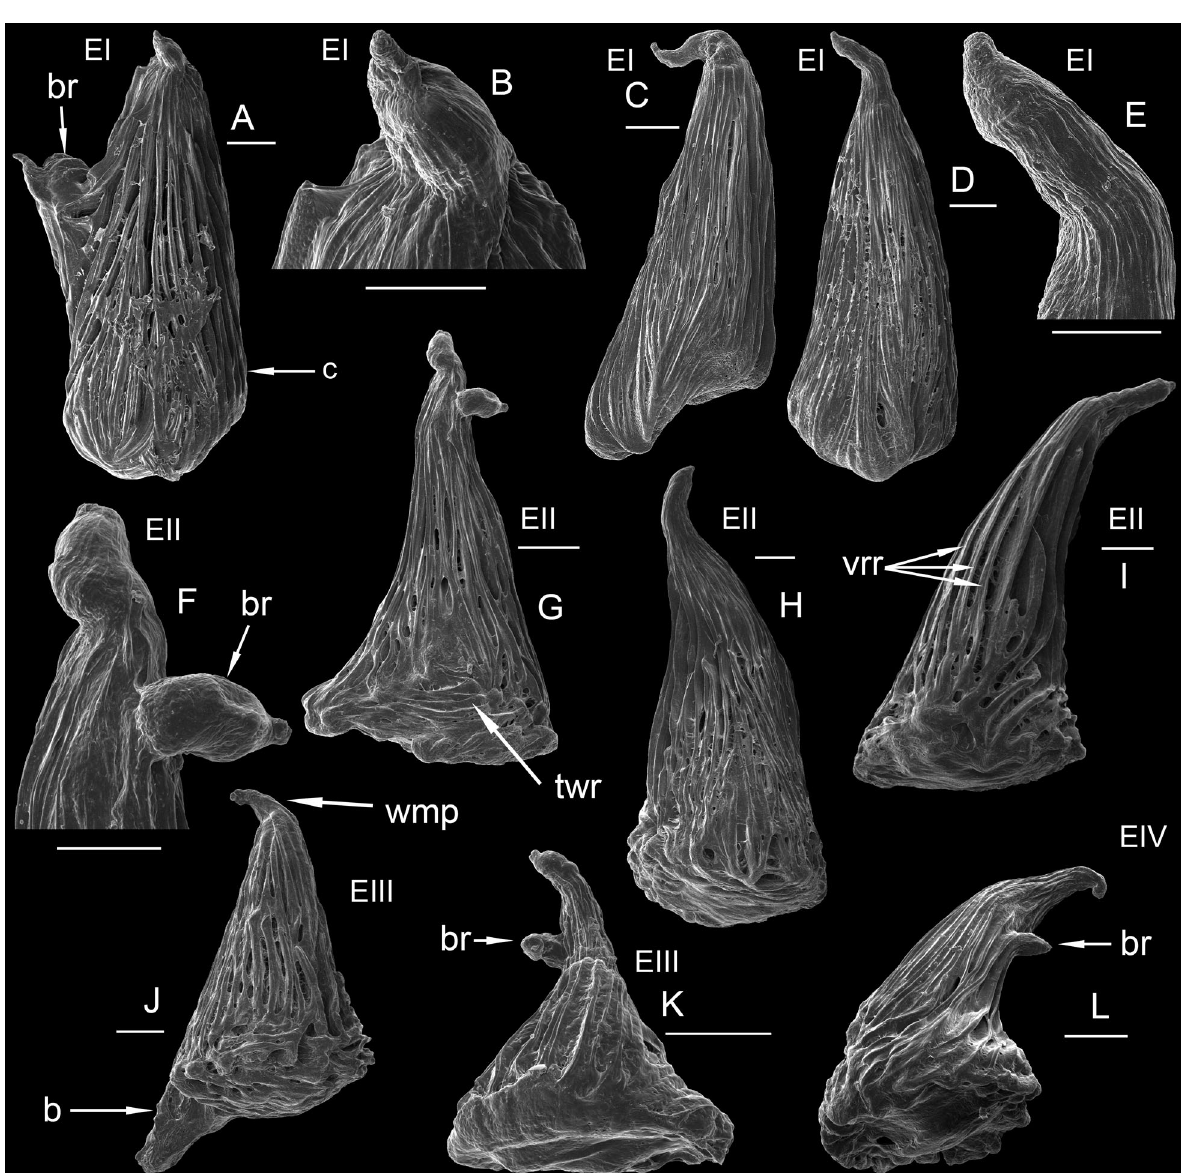
Fig. 7. Platichthys flesus trachurus (Duncker). Cores of gill rakers from the 1st to 4th arches of the eye side (EI–EIV). A = B, GIT 584-118-1; C, GIT 584-118-2; D = E, GIT 584-118-3; F = I, GIT 584-118-10; G, GIT 584-118-8; H, GIT 584-118-9; J, GIT 584-118-16; K, GIT 584-118-15; L, GIT 584-118-20. Scale bar for A, C, D, G–L is 200 µm, for B, E, F 100 μ m. Abbreviation: twr, twisted ribs of gill raker core. For other abbreviations see Fig.